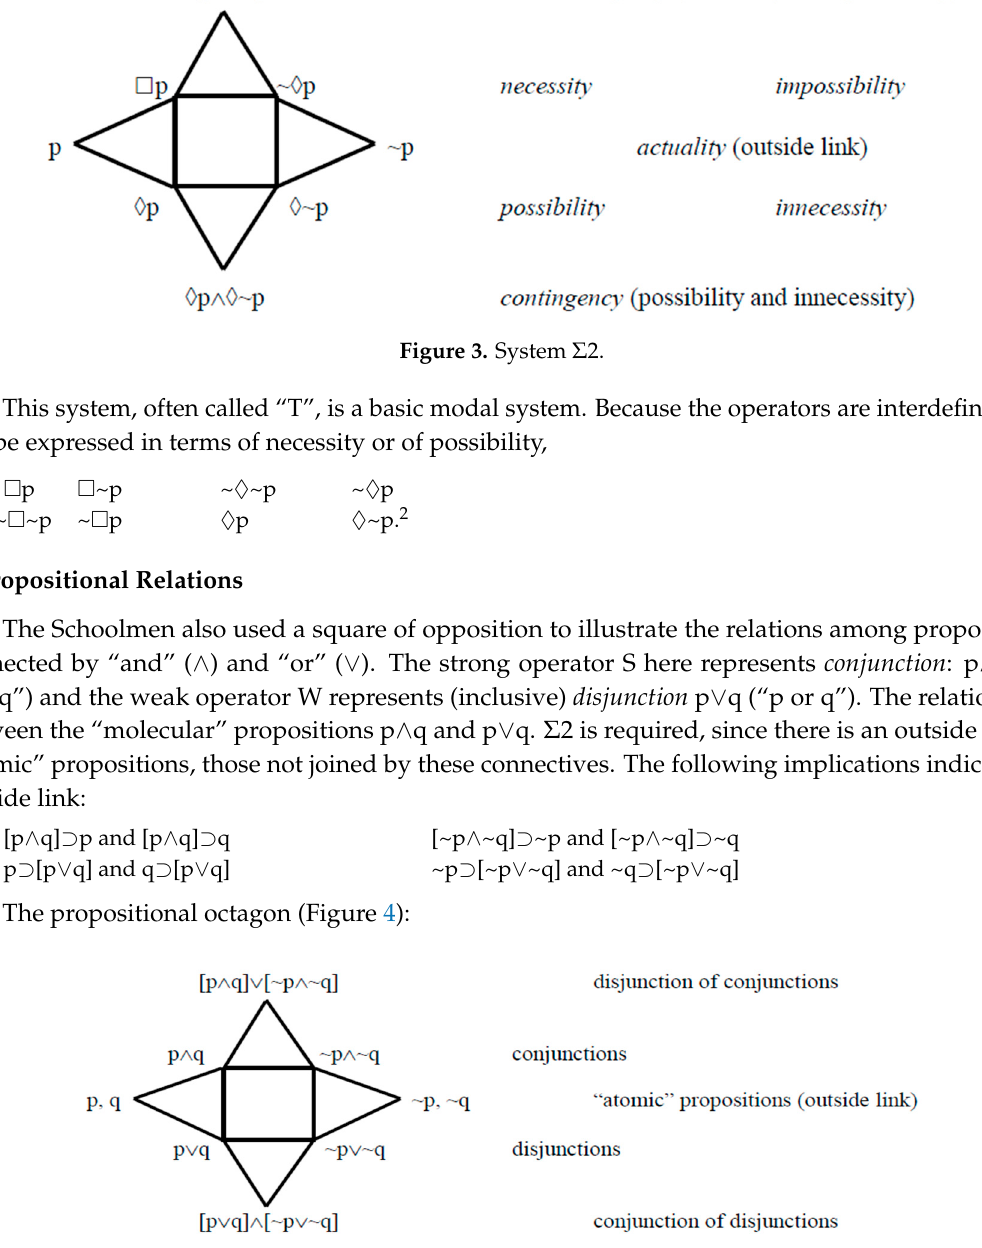
Figure 4. The propositional octagon.